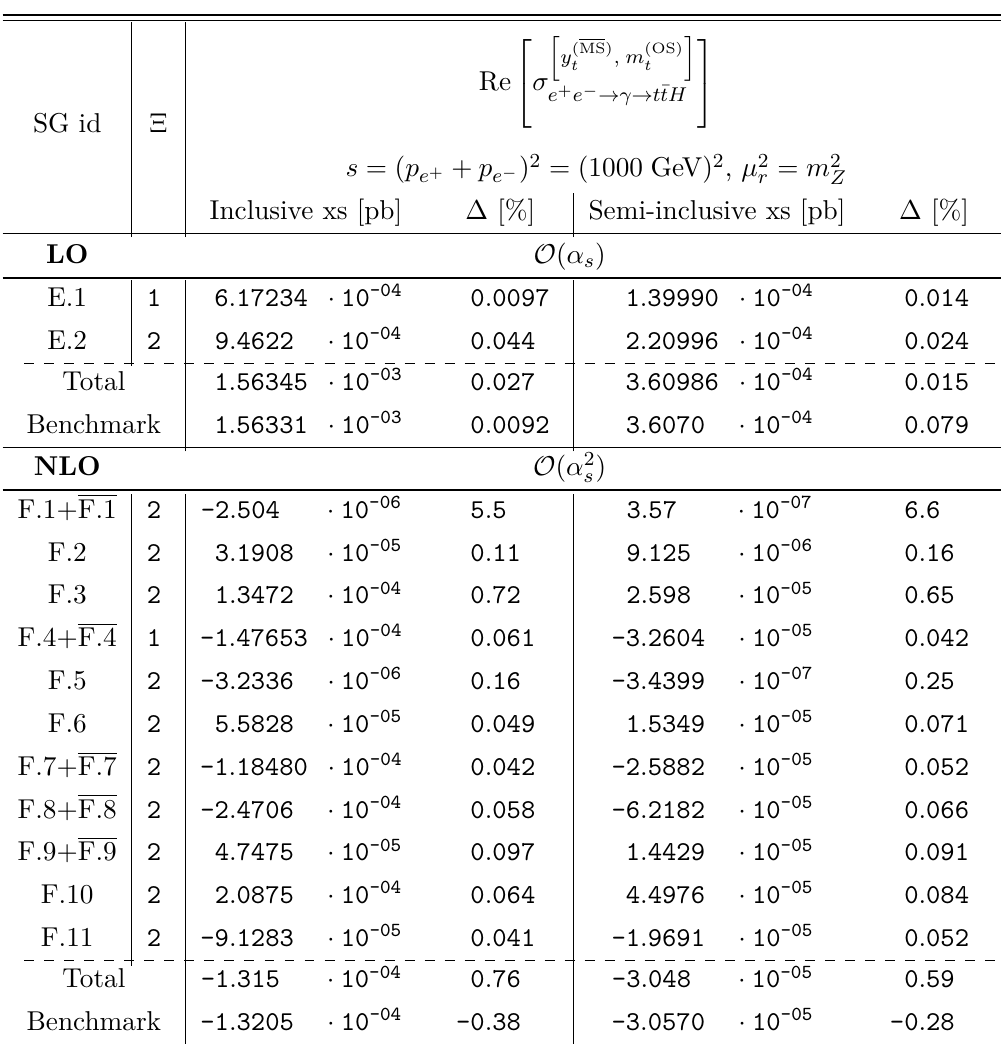
Table 6. Contributions from individual supergraphs listed in table 13 to the cross-section up to table. 1 except that the top-quark mass is renormalised in the OS scheme here, and not in MS. We show results for both the fully inclusive cross-section and for a semi-inclusive one with fiducial cuts given in eqs. 6.5. The entries labelled “F.i+F.i” report the result for the sum of the contribution from both isomorphic supergraphs F.i and F.i. Ξ denotes the symmetry factor of the supergraph (included in the result reported). ∆ reports the relative Monte-Carlo error, except for the “Benchmark” entry where it refers to the relative difference w.r.t. the LU result instead. The benchmark results are obtained in this case from MG5aMC [99] and are themselves subject to a 0.1% MC